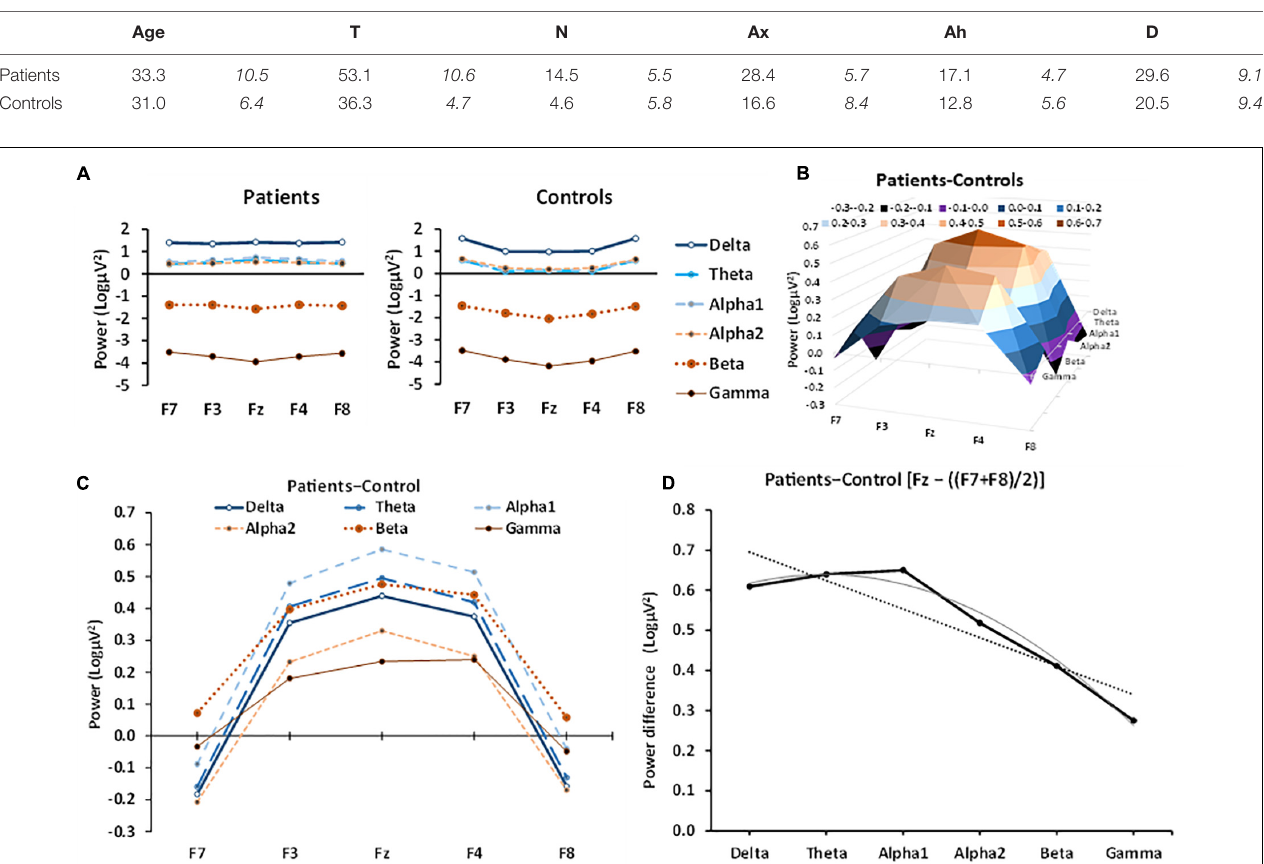
FIGURE 1 | Patient and control EEG power in the different bands across frontal channels. (A) Patient power curves are relatively flat across each channel for most bands with the possible exception of gamma, while control power curves generally have an inverted U-shape. (B) 3D representation of the effect of anxiety (patient-control power difference) in different bands at frontal-central electrodes, showing the systematic left-right channel × band frequency variation, detected statistically by a significant channel[quadratic] × frequency[linear] interaction. (C) The same data as in B but with different bands plotted against channel as overlapping curves to allow numerical comparison (frequency of the band is coded by line thickness). The anxiety effect for each band was an inverted-U function of channel; that is, the strongest difference in power was in the central channel, with minimal anxiety effects in the lateral channels. (D) Linear trend and quadratic trend of band frequency fitted to power values for Fz minus the average of F7 + F8 (which approximates the quadratic trend across channel). There is a significant decrease in this component from delta to gamma (the dotted line shows the significant linear trend). There appears to be some non-linearity, with an apparent peak at alpha1. The curved line shows the combination of the linear trend with the apparent slight, non-significant ( p = 6%), quadratic trend.